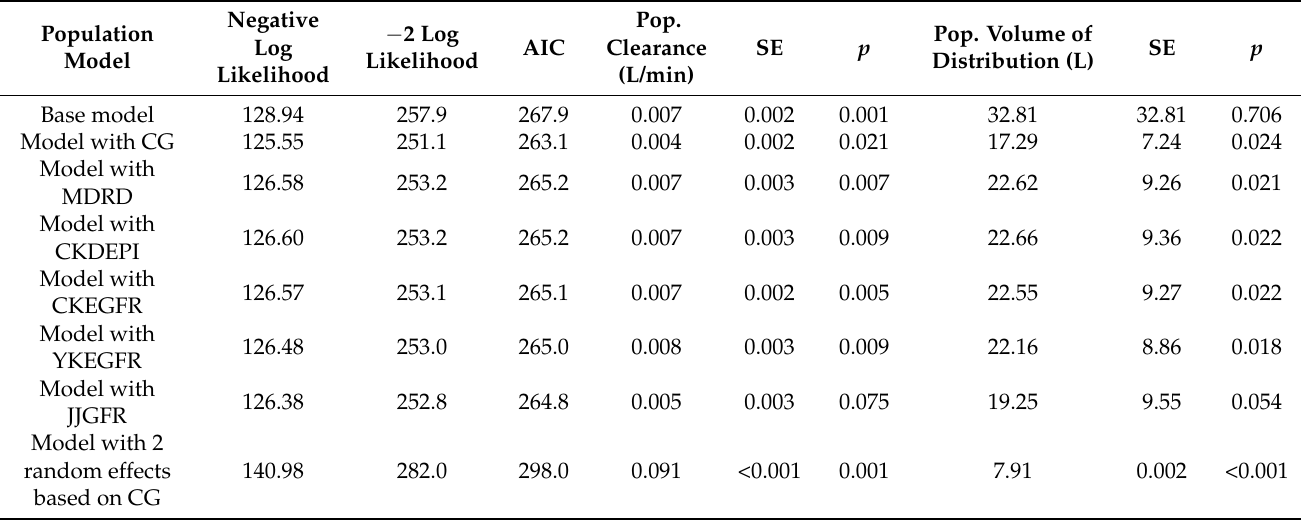
Table 4. Developed population pharmacokinetic models, n = 34.